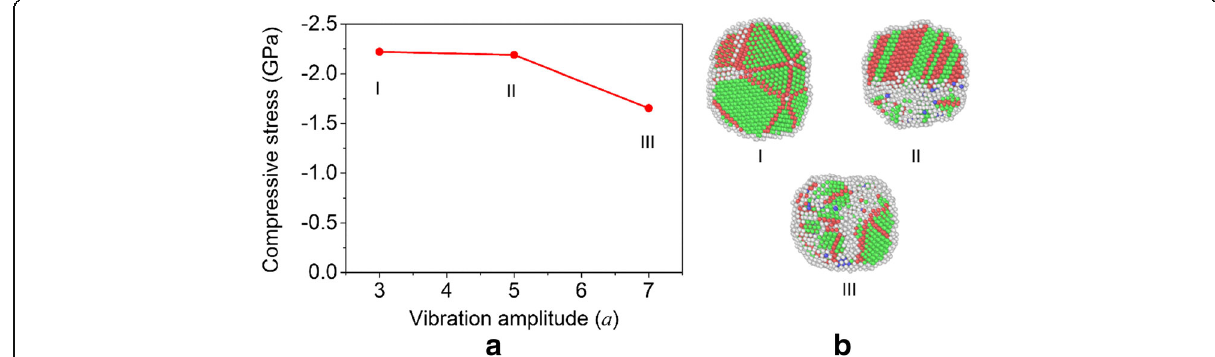
Fig. 12 Influence of the vibration amplitude on the mechanical properties of sintered nanoparticles. a Final compressive stress as a function of vibration amplitude for the sintered particles. b Nanostructures of the nanoparticles sintered under different vibration